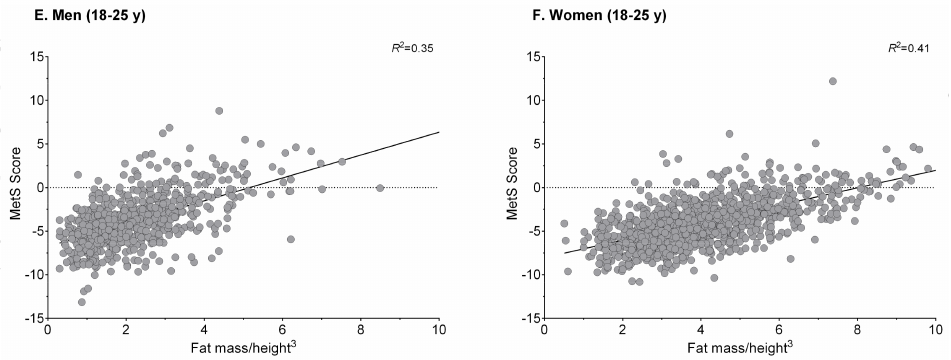
Figure 1. Association between fat mass index and MetS score for sex and age groups. MetS: metabolic syndrome.